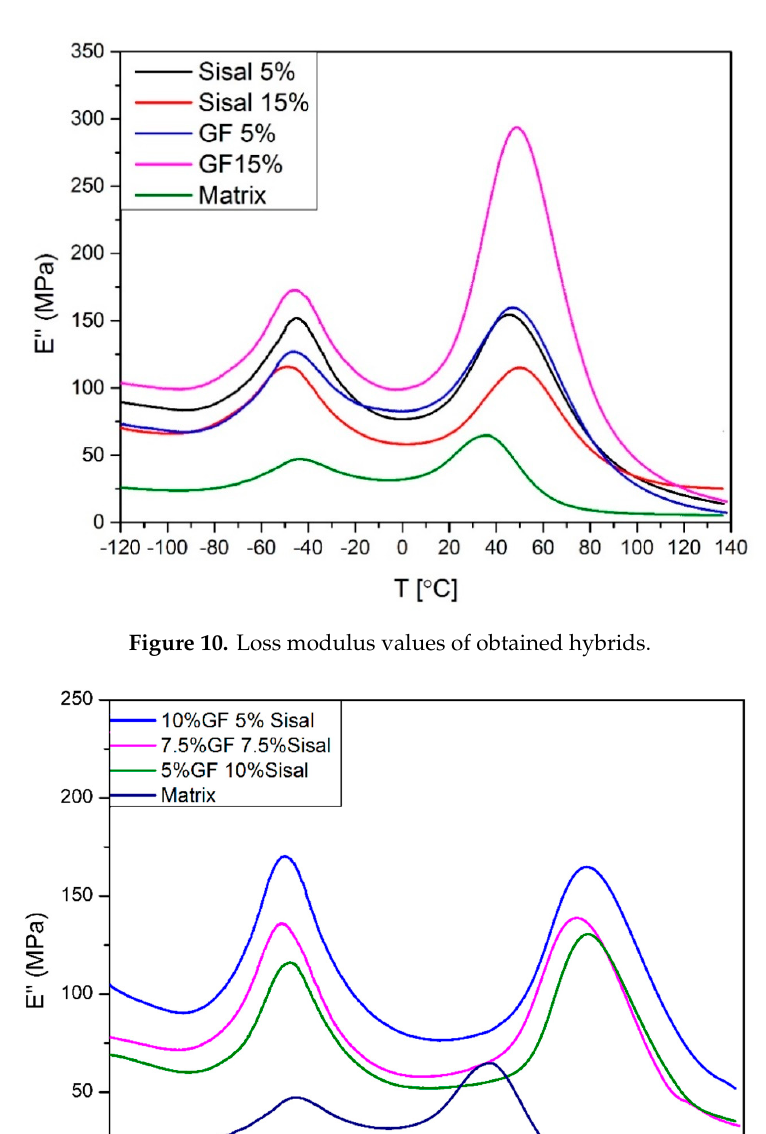
Figure 11. Loss modulus values of obtained hybrids.